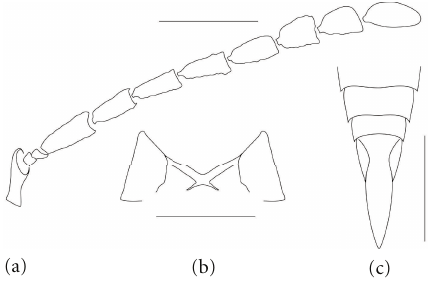
Figure 2: Details of Electropteron avus gen.n. , sp.n. , holotype male: (a) antenna; (b) prosternum; (c) apex of abdomen, ventrally. Scale: